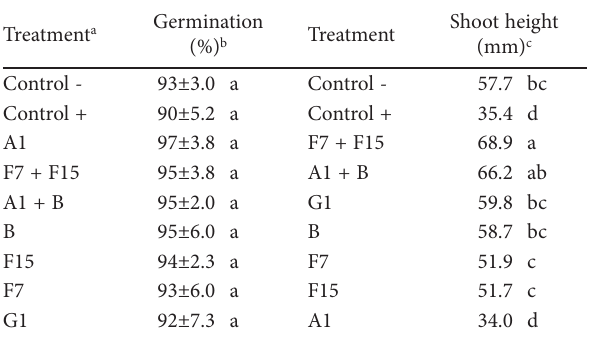
Table 4. Mean wheat seed germination and seedling heights from different bacterial endophyte isolate treatments applied to “Simeto” seeds artificially inoculated with Fusarium culmorum